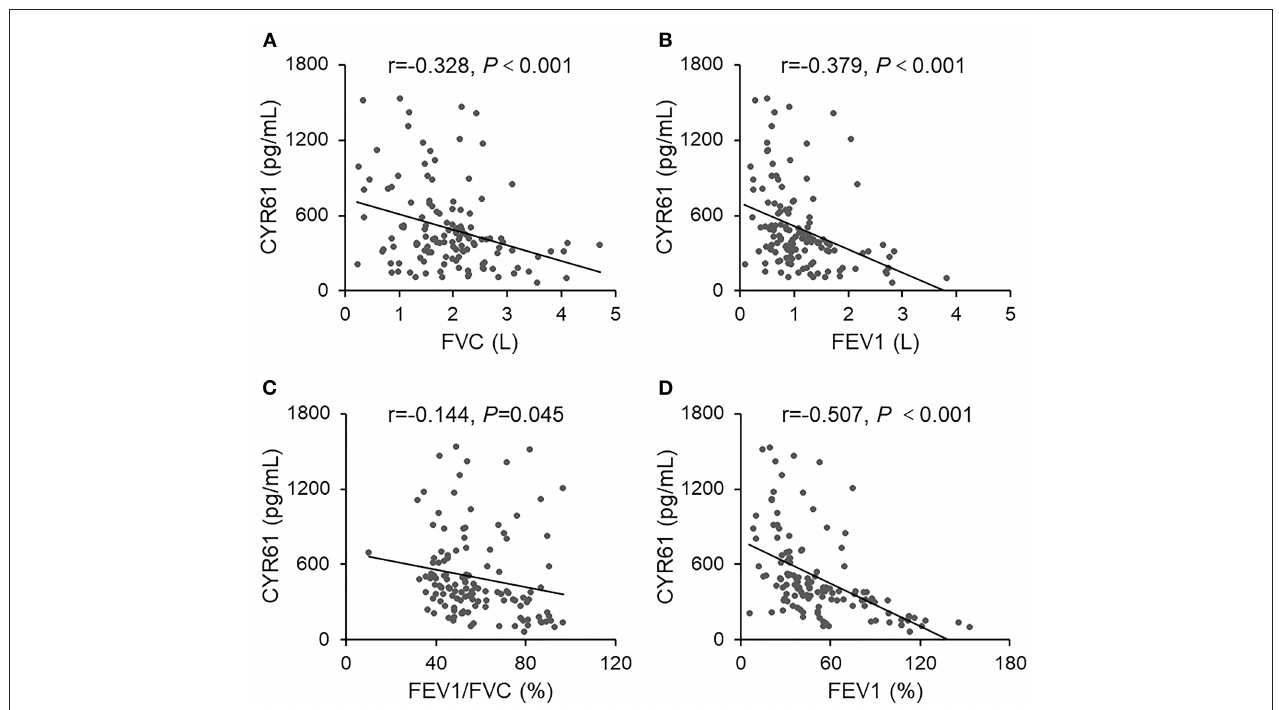
FIGURE 2 | The correlation between serum CYR61 and lung function indexes in COPD patients. Pulmonary function was measured in 150 COPD patients. Sera were collected and CYR61 was detected using ELISA. Correlation between serum CYR61 and lung function indexes was analyzed. (A) CYR61 vs. FVC(L); (B) CYR61 vs. FEV1(L); (C) CYR61 vs. FEV1/FVC (%); (D) CYR61 vs. FEV1(%).